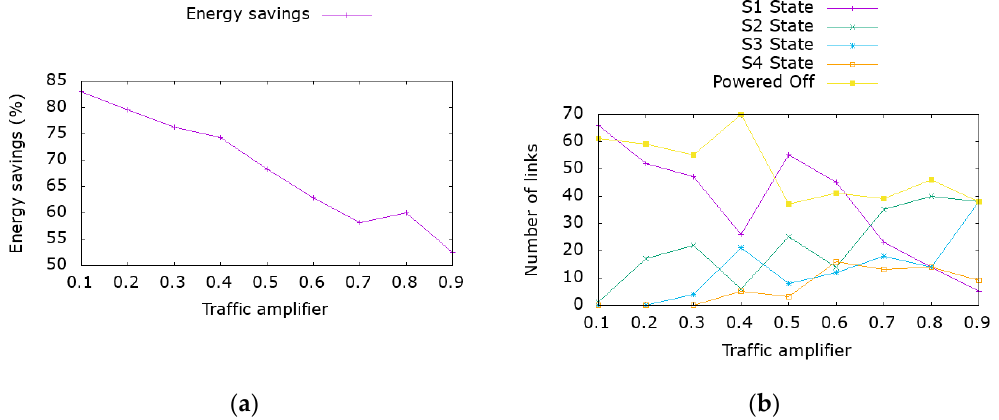
Figure 3. Analysis for average size leaf and spine topology under various traffic loads. ( a ) Energy savings from optimization algorithm. ( b ) Number of interfaces per state after the execution of the algorithm.